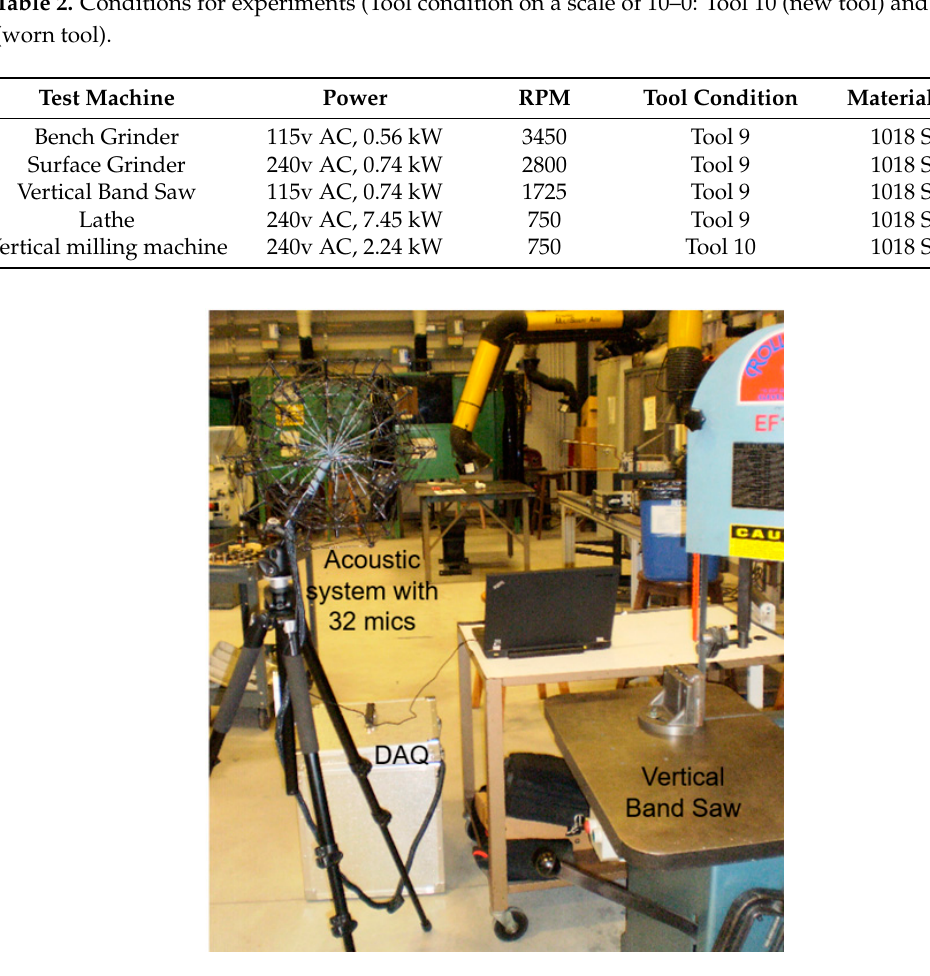
Figure 2. Experimental set-up for acoustic emission data collection with experimental conditions.